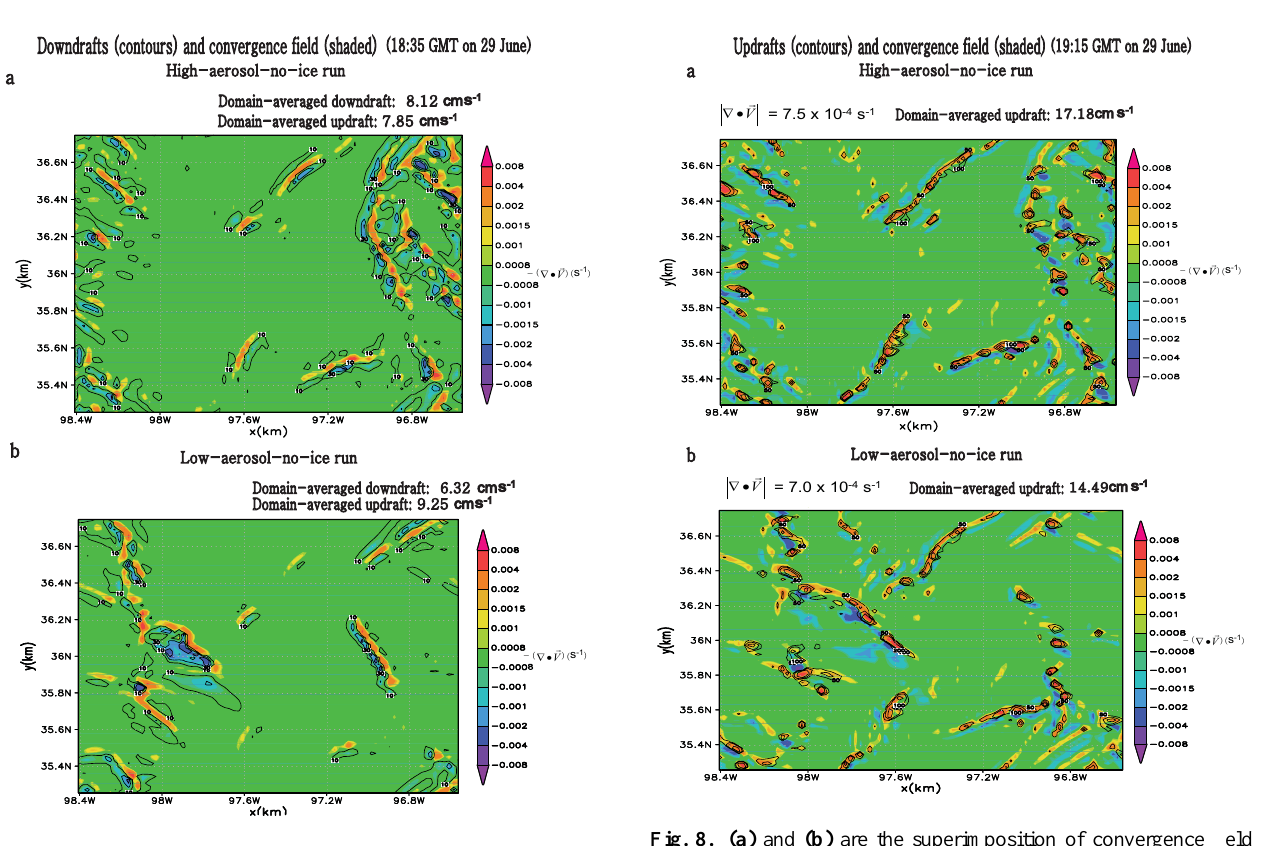
Fig. 7. (a) and (b) are the superimposition of the convergence field (s − 1 ) at the surface (represented by shading) and the vertically av- eraged downdrafts over the lowest 3km (represented by contours for 10, 30, and 50 (cms − 1 )) for the high-aerosol-no-ice run and the low-aerosol-no-ice run at 18:35GMT on 29 June. For ref- erence, domain-averaged downdrafts and updrafts over the lowest 3km and 4km (where most of condensation occurs), respectively, at 18:35GMT on 29 June are shown just above (a) and (b).